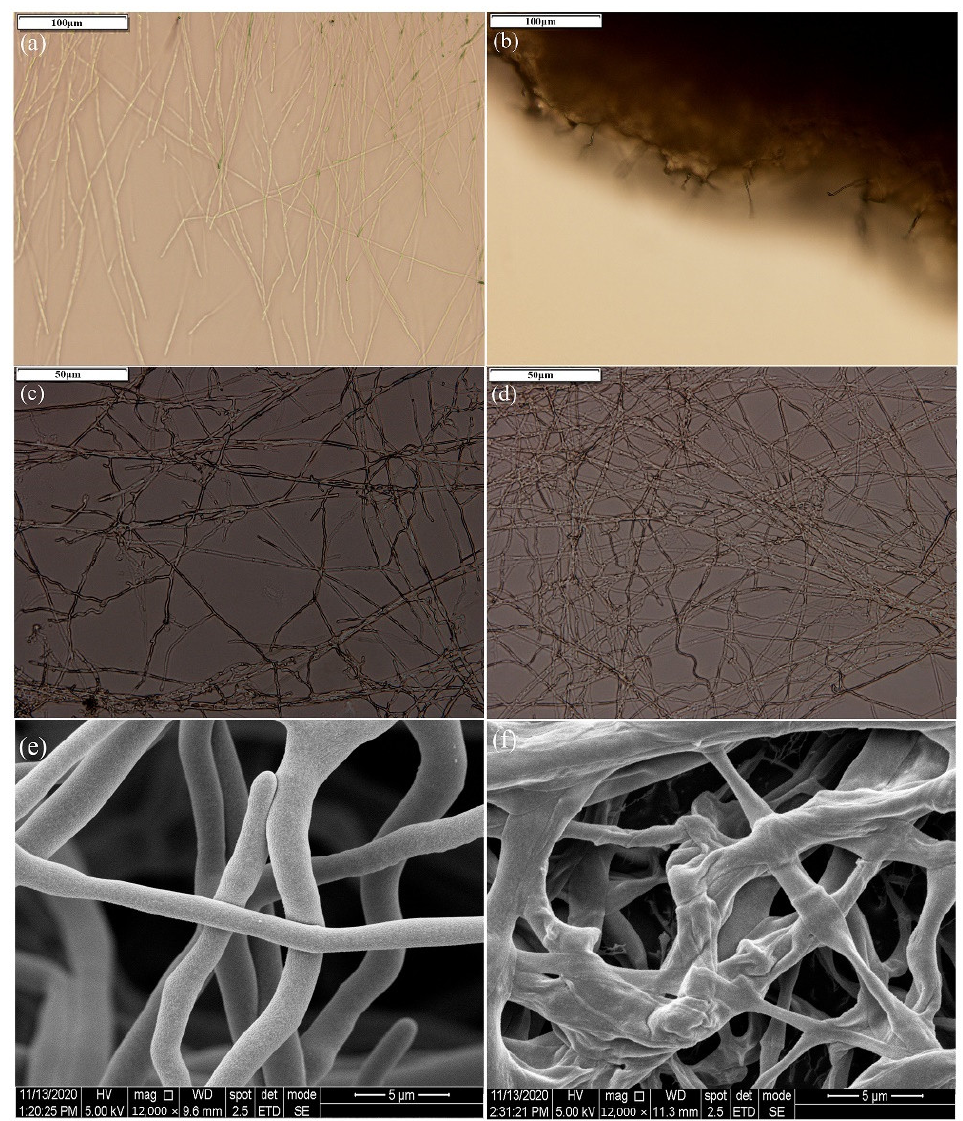
Figure 2. Effects of B. subtilis A-5 on mycelial growth and the morphological characteristics of M. grisea as observed using Olympus BX43 microscope ( a – d ) and Cryo-SEM ( e , f ). ( a , c , e ) refer to CK samples; ( b , d , f ) refer to fungal mycelia inhibited by B. subtilis A-5.